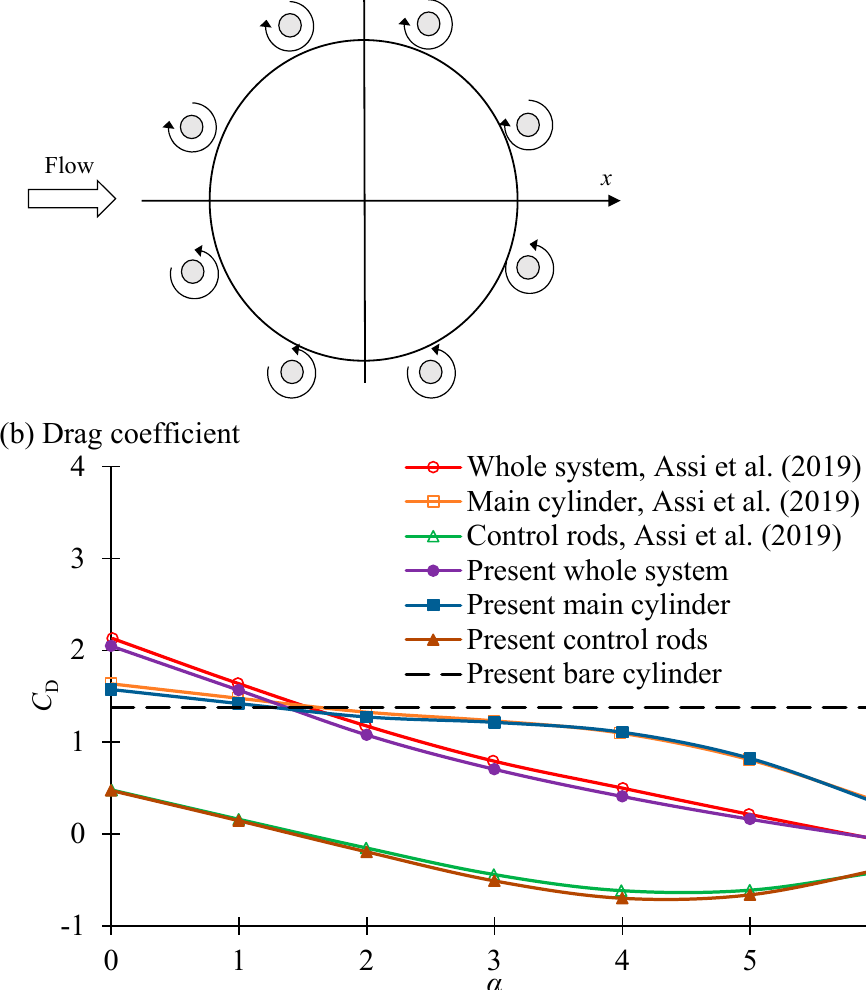
Figure 2. Comparison between present numerical results and the numerical results in Ref. [35] for flow past one cylinder with eight control rods at d / D = 0.05, Re = 100, and G / D = 0.05.